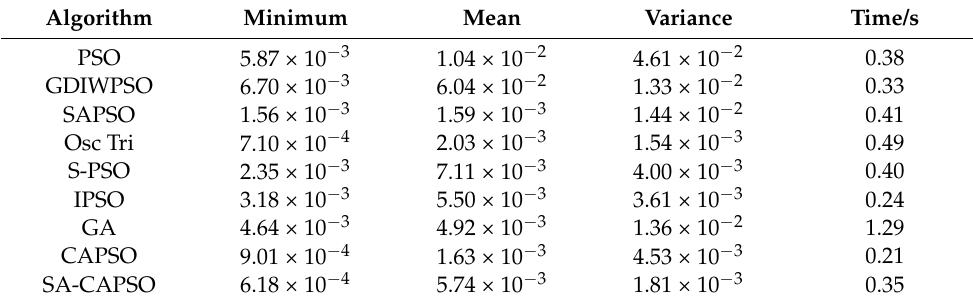
Table 12. Test results of test function F5.